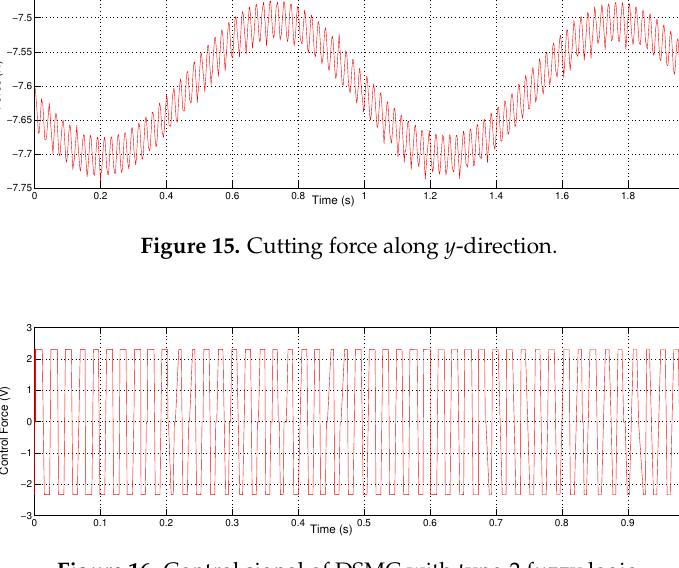
Figure 16. Control signal of DSMC with type-2 fuzzy